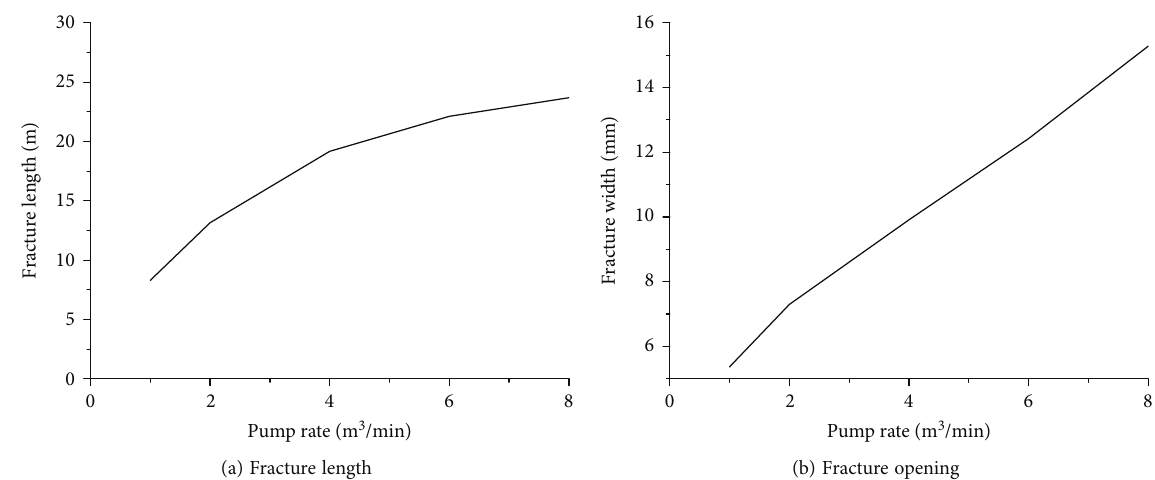
Figure 40: Fracture length and width at the NF approaching angle of 60 ° and injection rates of 1-8m 3 /min.